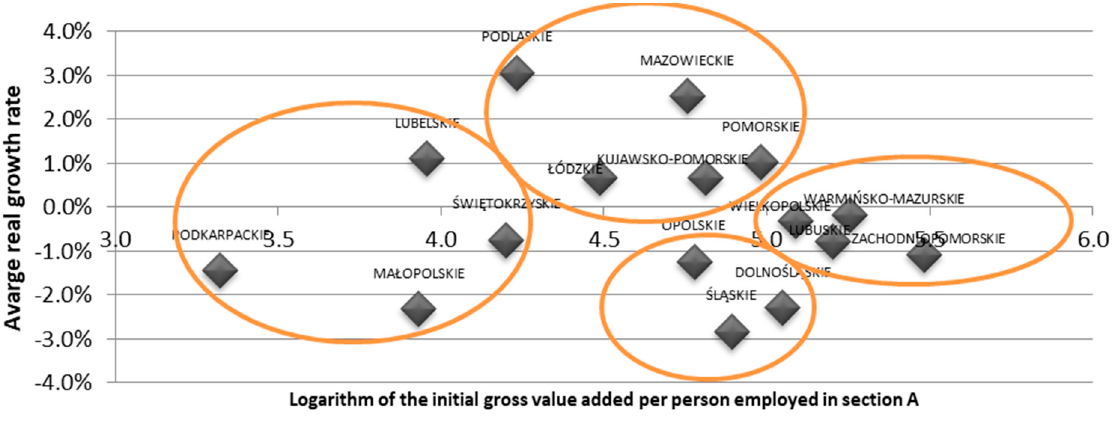
Figure 5. Beta-convergence analysis of the gross value added per person employed in section A (agriculture, forestry, hunting, and fishing) for voivodeships in 2003–2019 (own study, based on the Local Data